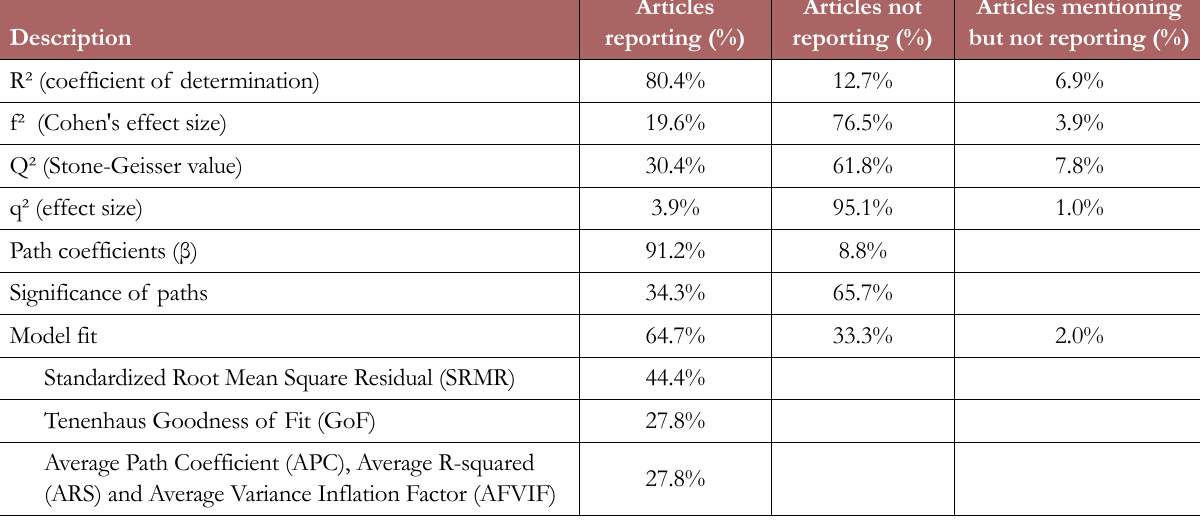
Table 8. Inner model evaluation (N=102)